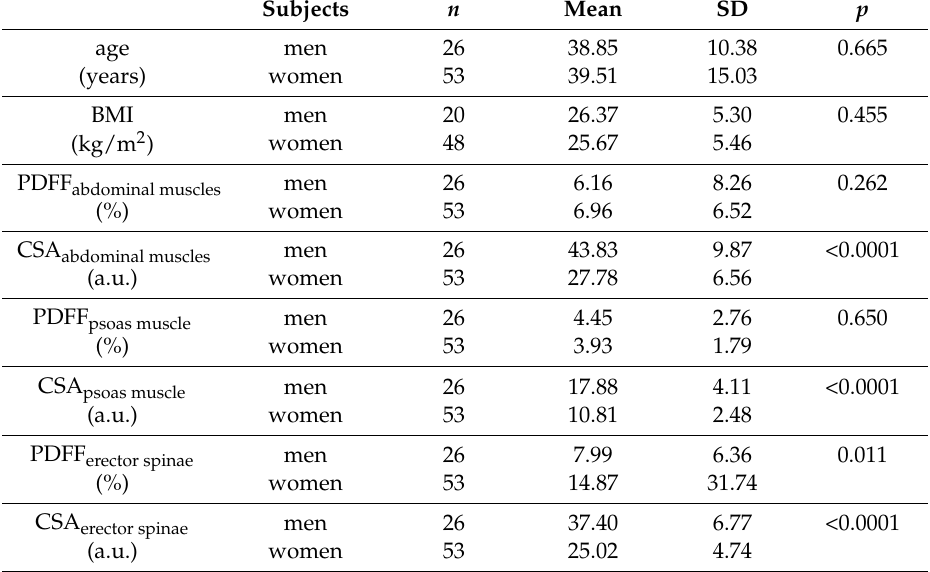
Table 1. Subject characteristics (age and body mass index (BMI)), PDFF values, and cross-sectional area (CSA) of abdominal muscles, psoas muscle, and erector spinae. Parameters were compared between the two groups with Mann–Whitney tests ( p